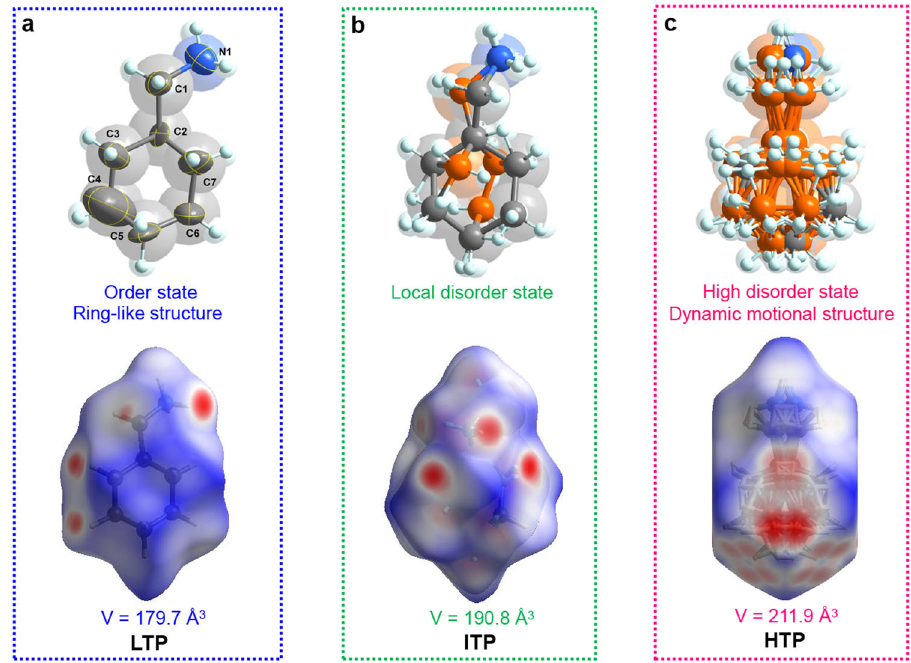
Fig. 3 | Temperature-dependent variationoforganic spacingcationduring thesuccessivephasetransitionsof1. Order-disordertransformation (top)and Hirshfeld d norm surfaces (bottom) of CHMA + cations are compared between a LTP, b ITP and c